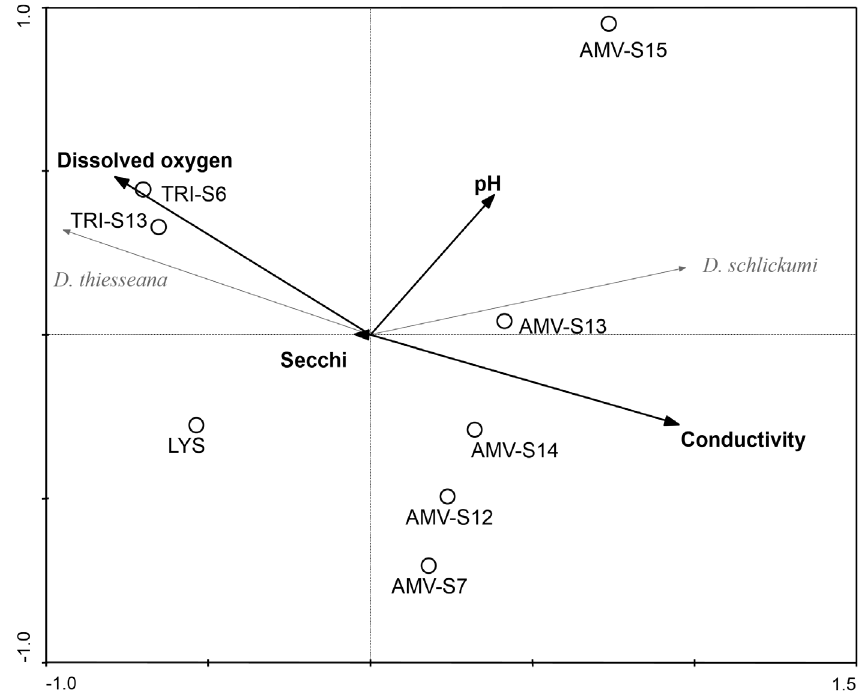
Figure 7. RDA ordination diagram of Dianella thiesseana and Dianella schlickumi abundances at sam- pling sites (circles) in relation to environmental parameters in lakes Trichonis (TRI), Lysimachia (LYS) and Amvrakia (AMV) in spring 2014 and 2015.